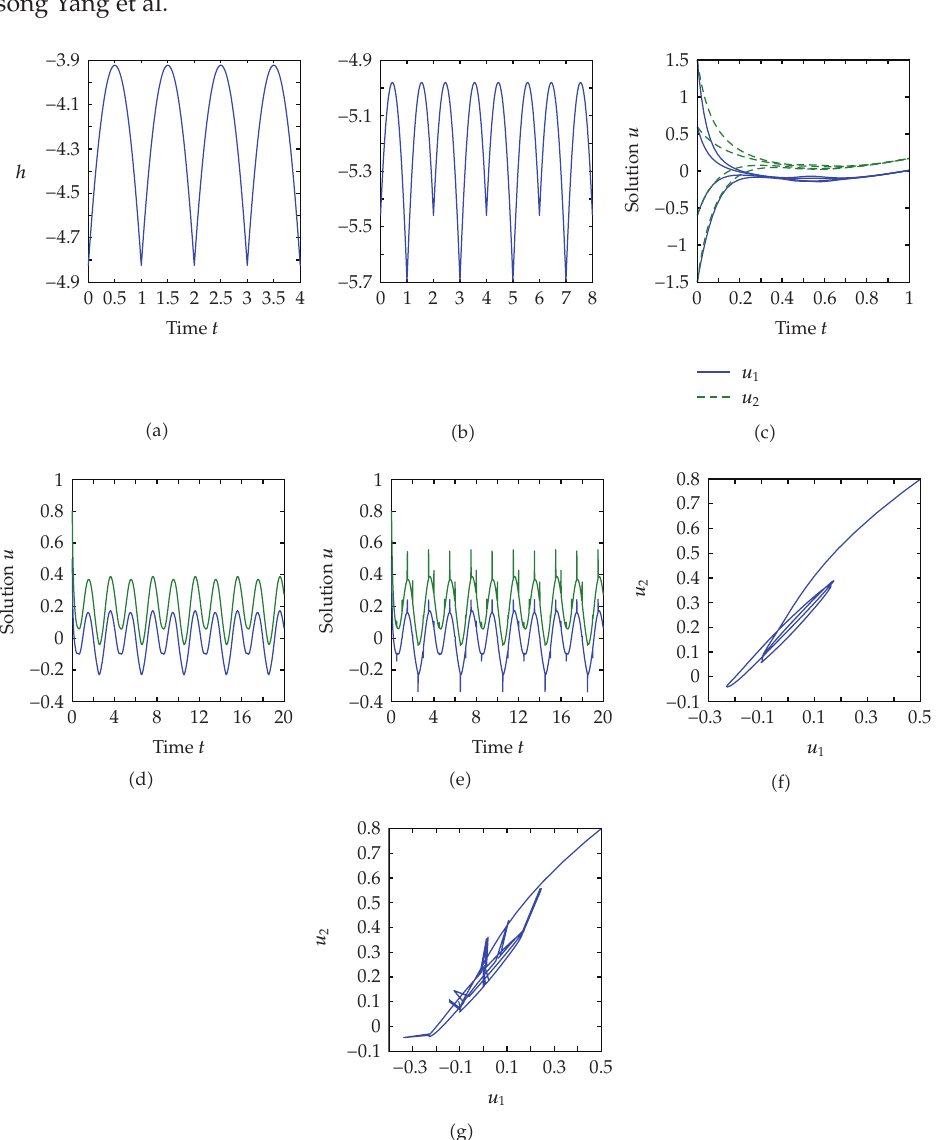
ln M k / (cid:2) t k − t k − 1 (cid:3) (cid:8) ln 2 . 04 (cid:8) 0 . 7129 < 1. Submitting λ (cid:8) 1 into (cid:2) 4.9 (cid:3) , we have h 1 (cid:2) λ (cid:3) < − 3 . 9 < 0, h 2 (cid:2) λ (cid:3) < − 4 . 9 < 0, (cid:2) see Figures 1 (cid:2) a (cid:3) and 1 (cid:2) b (cid:3)(cid:3) . This implies that ln 2 . 04 < 1 < α . Hence,